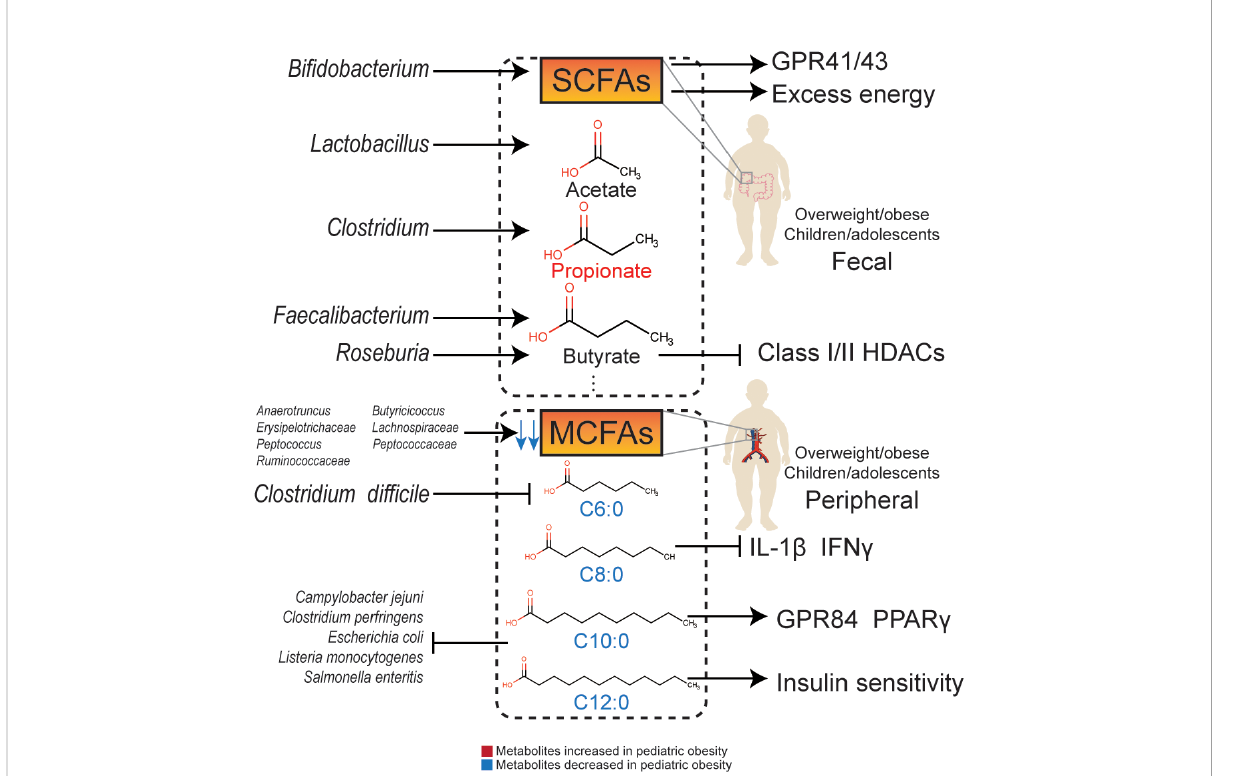
FIGURE 1 The relationship and molecular signaling between gut microbiota and their metabolites with